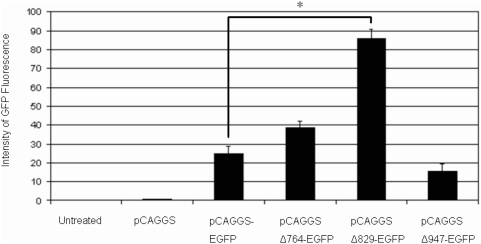
Expression intensity of EGFP reporter gene in transfected HEK 293T cells as determined by FACS.Portions of the 5′ untranslated region of pCAGGS downstream of the CAG promoter were systematically removed generating pCAGGSΔ764-EGFP, pCAGGSΔ829-EGFP and pCAGGSΔ947-EGFP. Assays were preformed in triplicate and repeated twice, the data shown is from one experiment. Error bars represent the standard deviation of the data. * p<0.001.